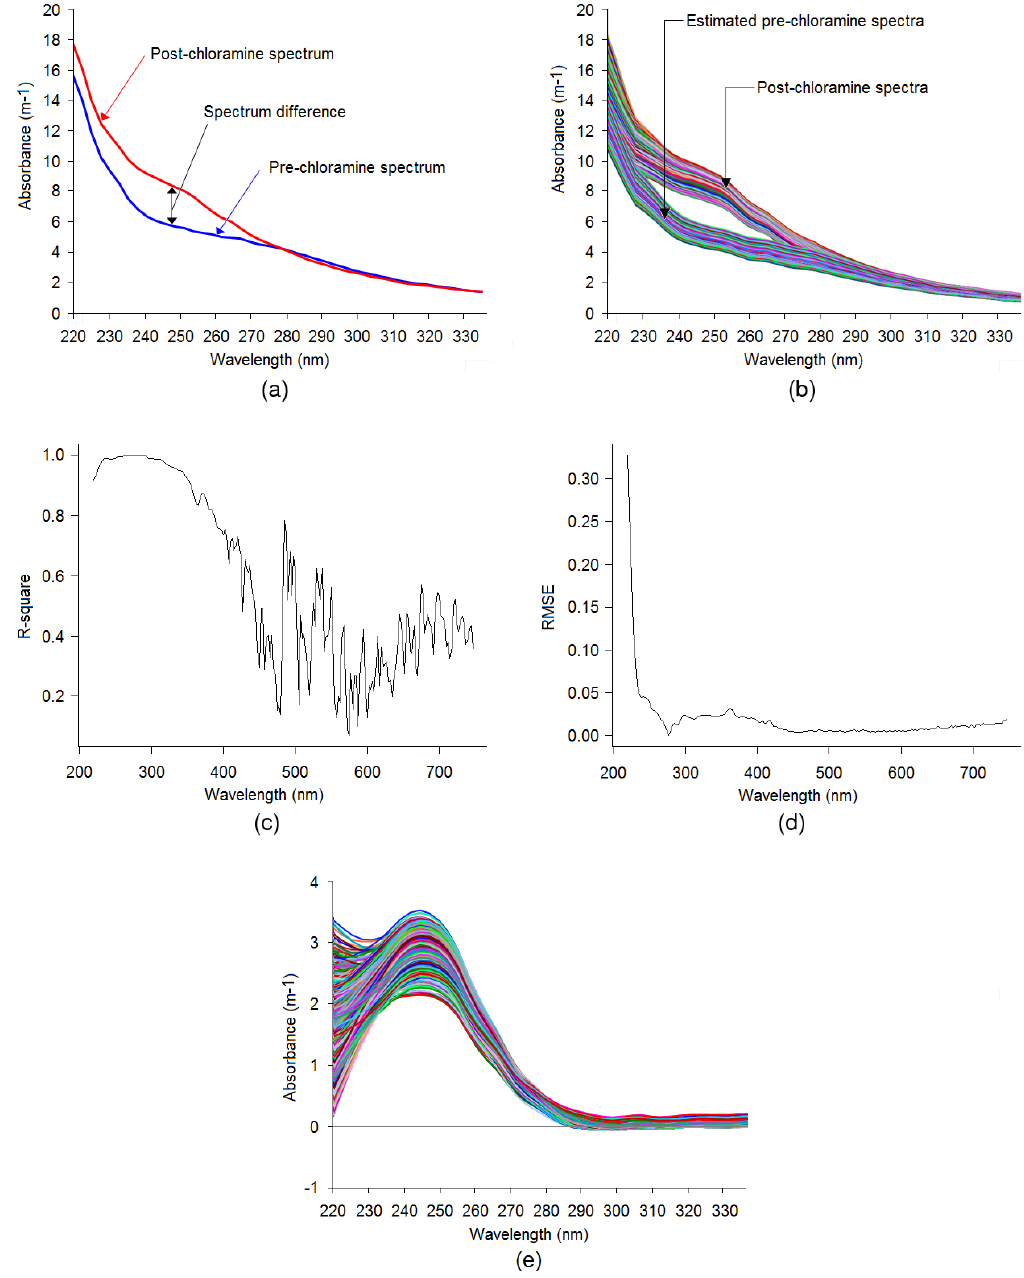
Figure 9. ( a ) Typical pre and post chloraminated spectra recorded at the WTP. ( b ) Comparison of estimated pre-chloraminated spectra and original post-chloramination spectra. ( c ) Coefficient of determination values in polynomial model fitting for various wavelengths. ( d ) Root mean square error (RMSE) values for polynomial fit. ( e ) Estimated DOC and NO 3 -N compensated (NH 2 Cl) spectra.